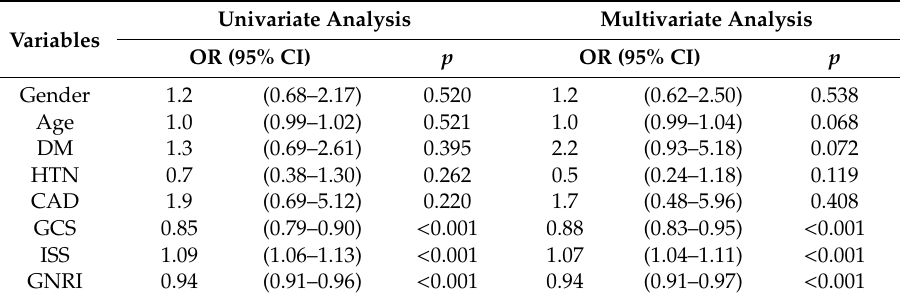
Table 2. Univariate and multivariate analysis of the risk factors for mortality.